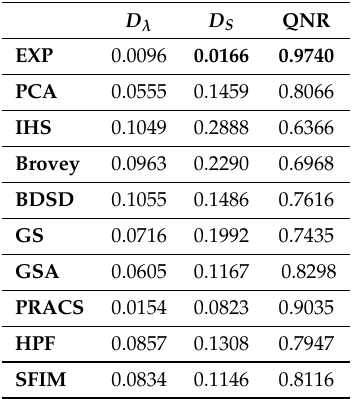
Table 4. QNR Quantitative results on the LANDSAT 7-ETM+ Chesapeake Bay image. Bold values indicate the best